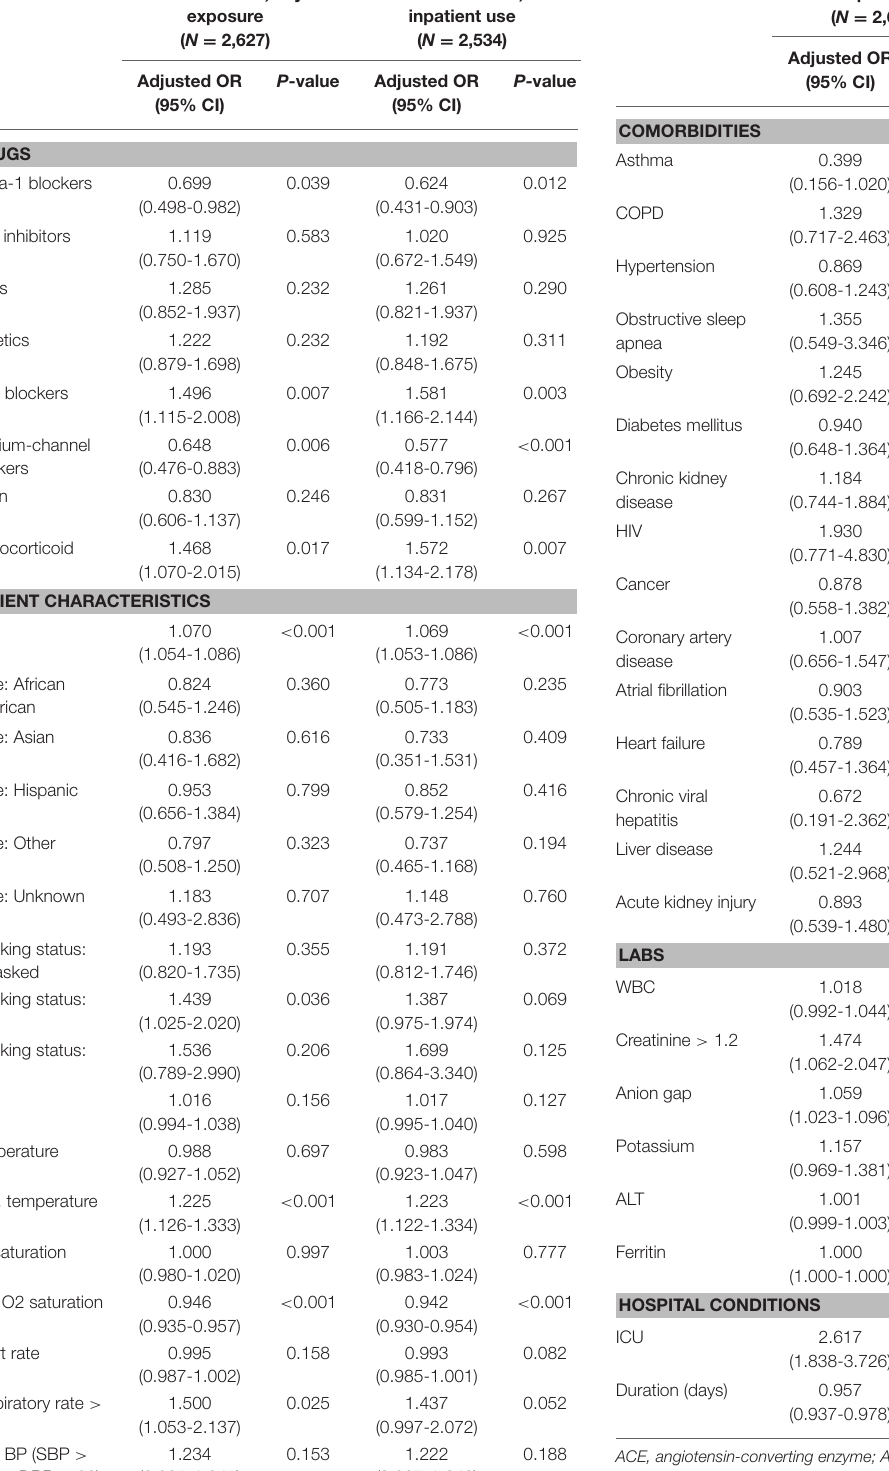
TABLE 2 | Multivariable logistic regression results for COVID-19 in-hospital mortality, by alpha-1-blocker exposure (any vs. inpatient use). Overall cohort, any